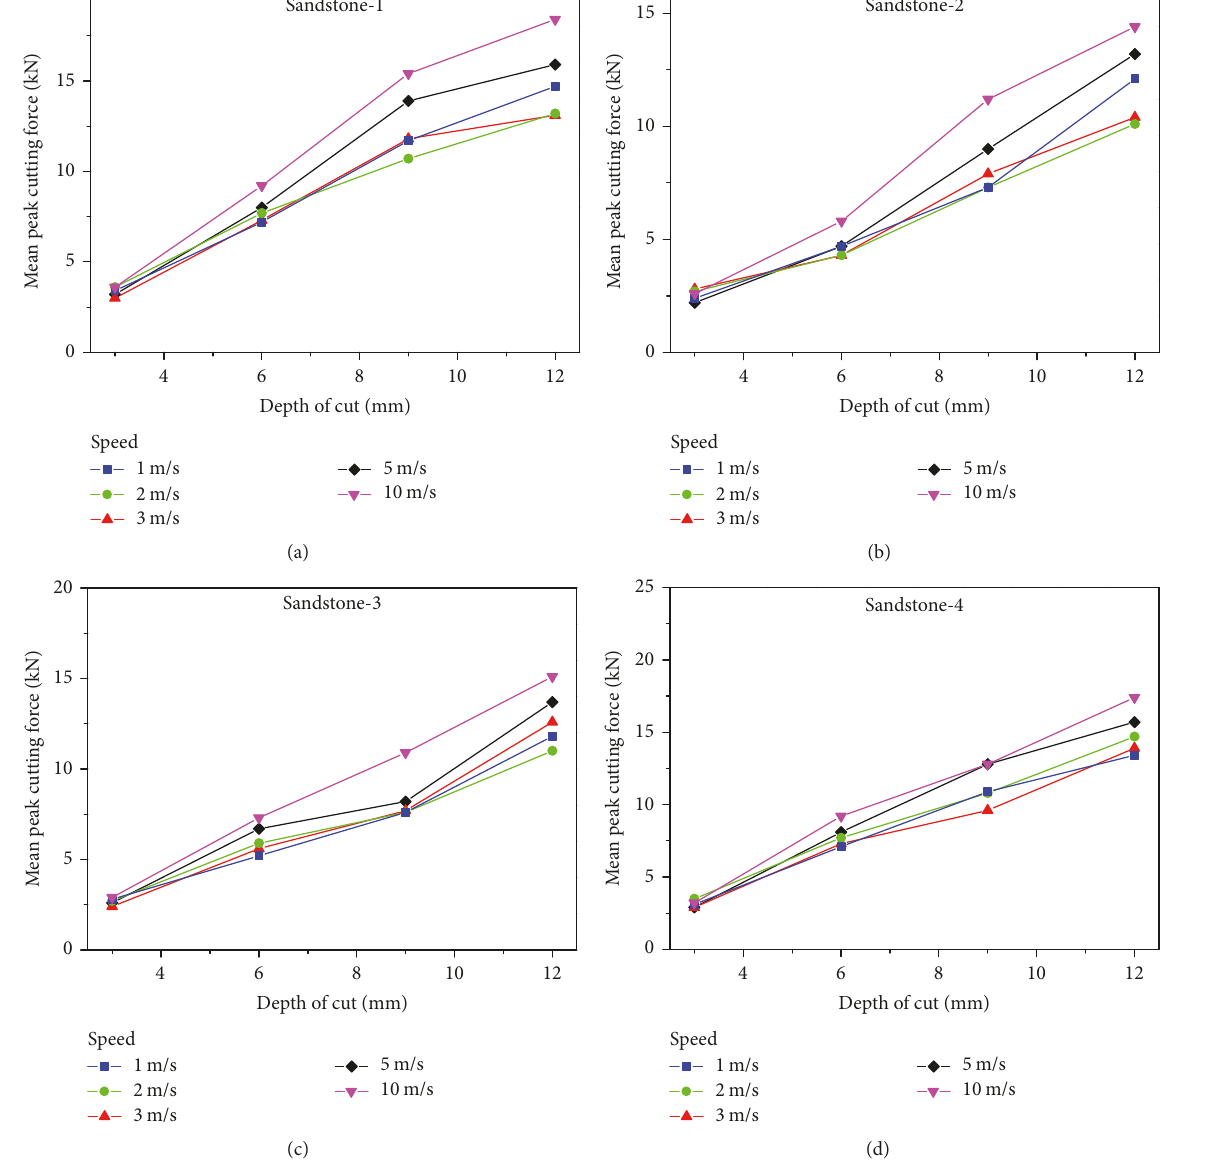
Figure 10: The variation in the mean peak cutting force with the cutting depth for different rock types: (a) sandstone-1, (b) sandstone-2, (c) sandstone-3, and (d)